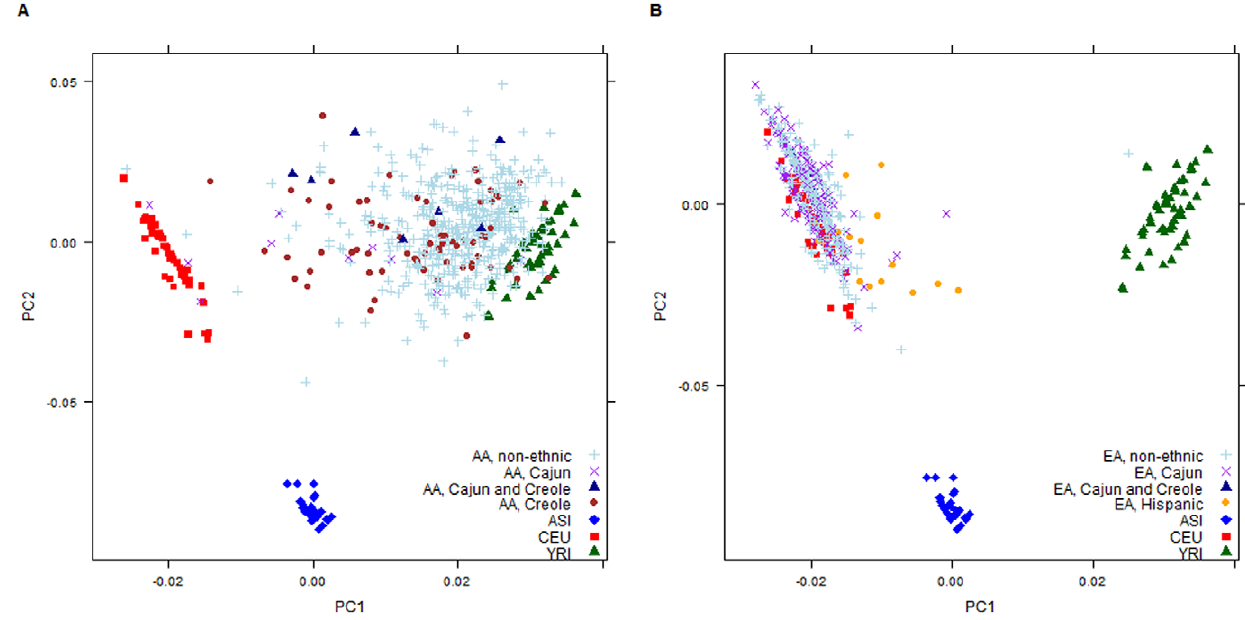
Figure 2. Clustering of self-reporting AA and EA research subjects in Louisiana with Hapmap, CEU, YRI and ASI (JPT + CHB) populations based on PC1 and PC2. Plots of AA ( a ) and EA ( b ) with self-reported ethnicity.